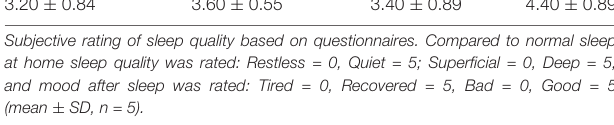
TABLE 2 | Objective sleep quality.